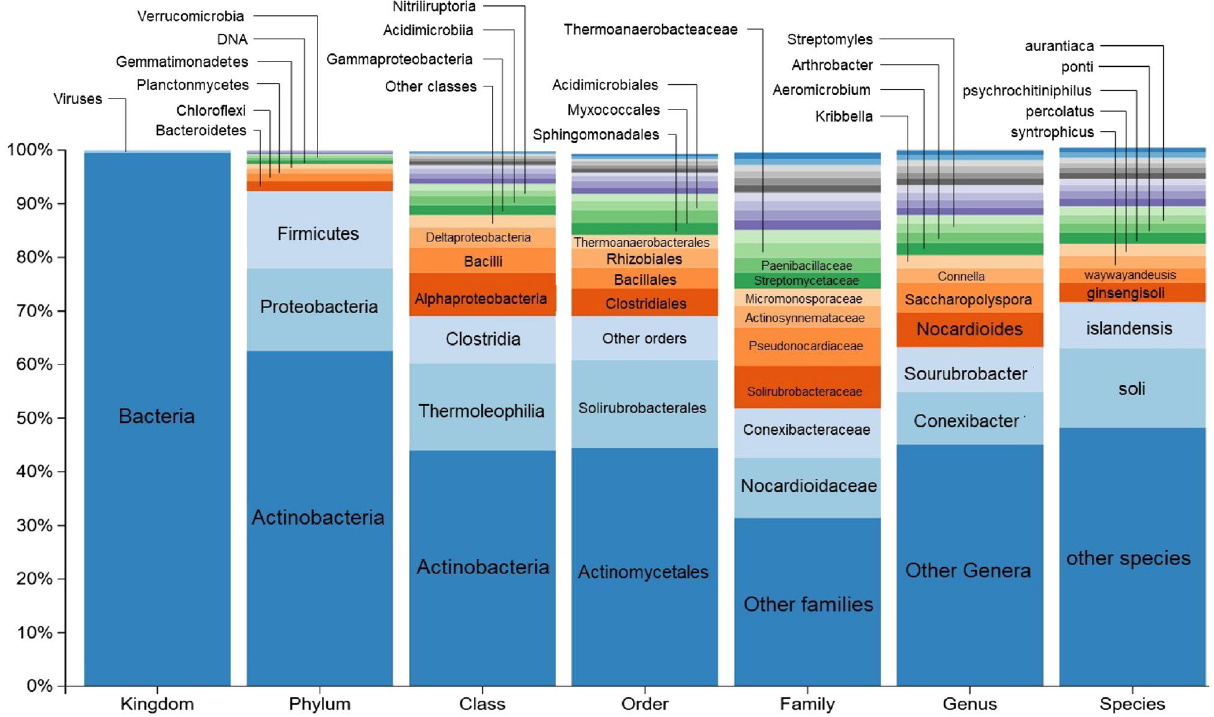
Figure 6. Relative abundance of microorganisms in the soil sample within each taxonomic level. From left to right: kingdom, phylum, class, order, family, genus and